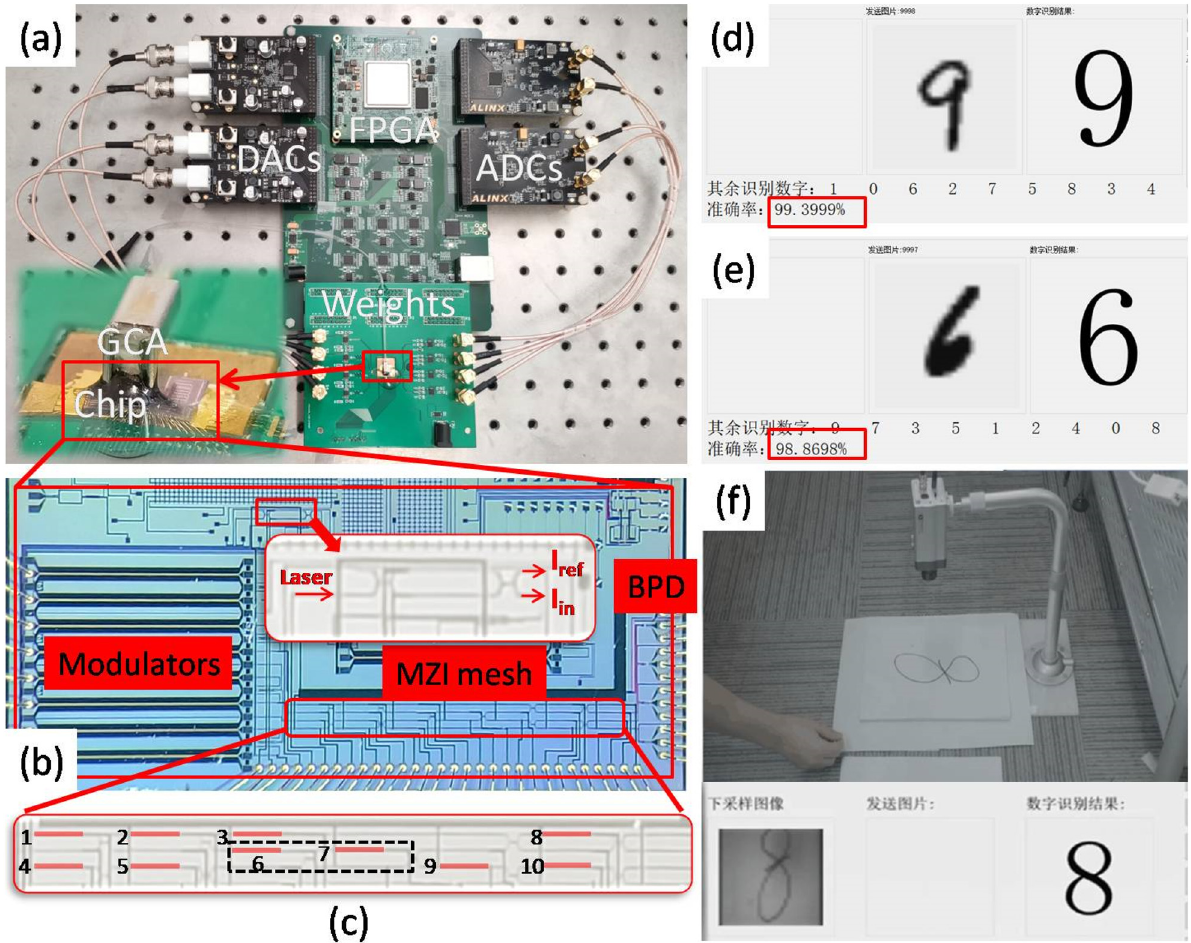
Figure 6: The system implementation of the PNN using pseudo-real-value MZI mesh. (a) PNN inferences system based on LeNet-5 network implemented on (b) silicon photonics chip with pseudo-real-value nonuniversal MZI meshdesign,where(c) aP-GridUnitarymeshwhere10thermalshiftersisemployedto program fi veMZIswithin(shifter1and2are θ and ϕ for 1st MZI, likewise, 4 and 5 for 2nd, 6 and 7 for 3rd, 3 and 8 for 4th, 9 and 10 for 5th). Tested MNIST accuracy when the chip works as (d) P-GridUnitary mesh or (e) FFTUnitary mesh. The demonstration of recognition of realistic hand-written digits captured by the